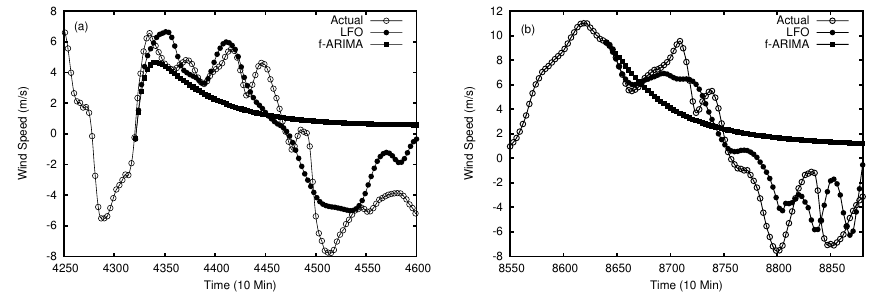
Fig. 13. Comparison of predicted values with the actual values for LFO and f-ARIMA. The symbols are plotted only at every 30 minutes for legibility. Latitude: 34.98420 ◦ N, longitude: 104.03971 ◦ W, (a) m = 13, τ = 3 and (b) m = 8, τ = 7.